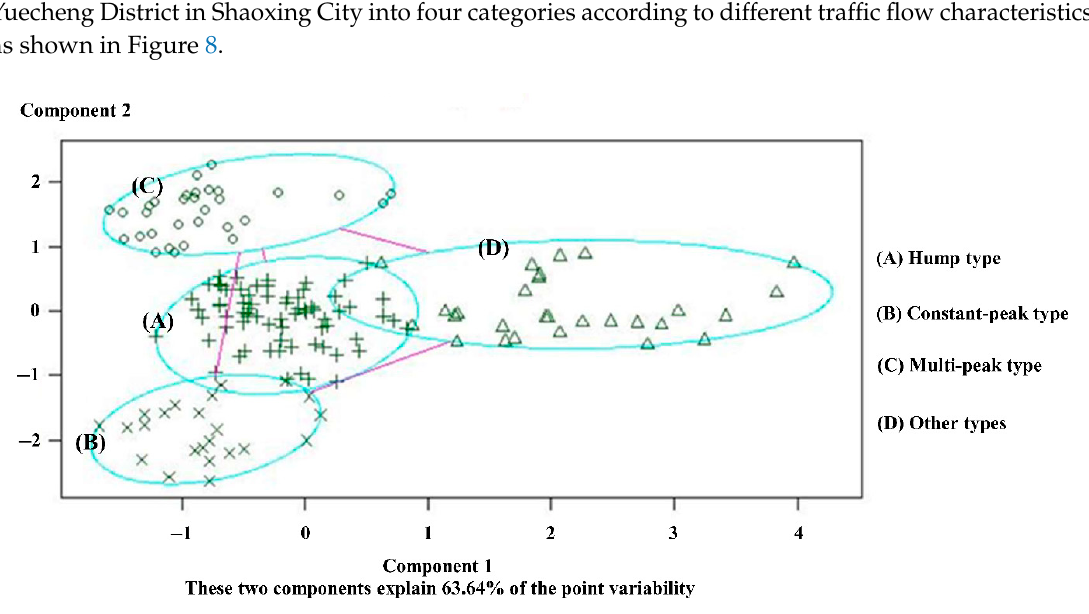
Figure 8. Simulation diagram of K central point clustering algorithm.